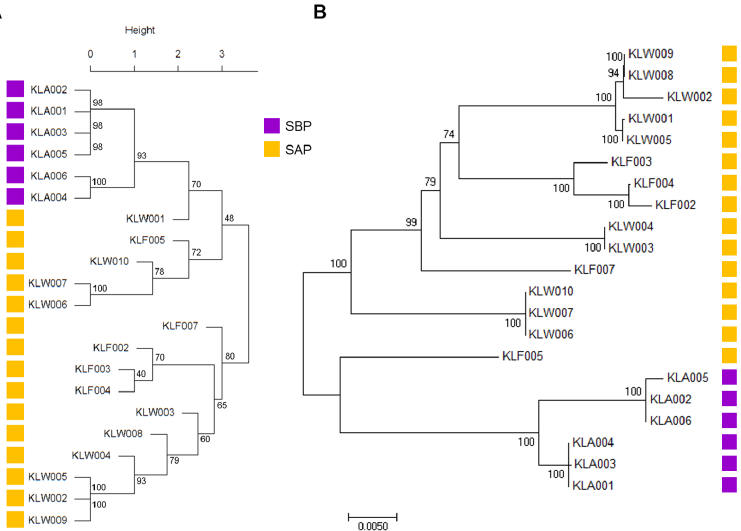
Fig 5. Phylogenetic clustering with extracellular protein genes of SAPs and SBPs. (A) Tree based on the presenceof 30 extracellular protein genes of SAPs and SBPs. (B) Hierarchical clusteringbasedon amino acid sequencesof the 14 core genes for extracellular protein. The bootstrapconsensustree inferred from 1,000 replicates is taken.